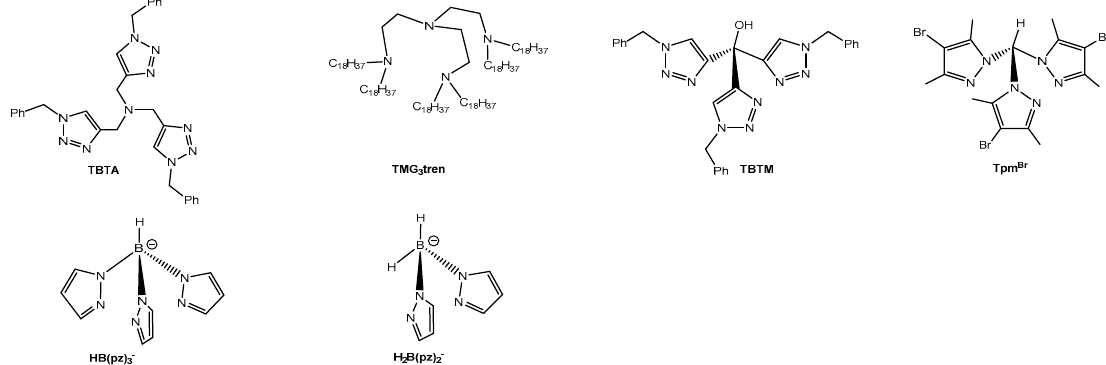
Figure 1. Structure of polydentate nitrogen ligands previously studied in copper(I)-catalyzed azide–alkyne cycloaddition (CuAAC) and the poly(pyrazolyl)borates tris(pyrazolyl)hydroborate (HB(pz) 3 − ) and bis(pyrazolyl)hydroborate (H 2 B(pz) 2 − ) explored in this